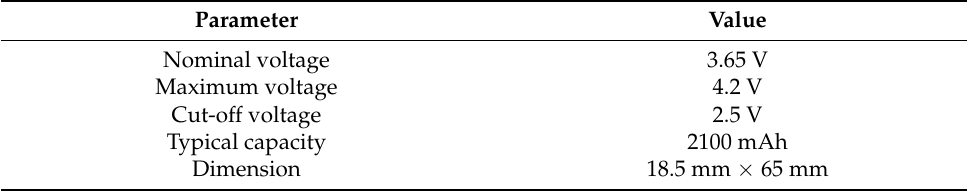
Table 2. DC battery information.